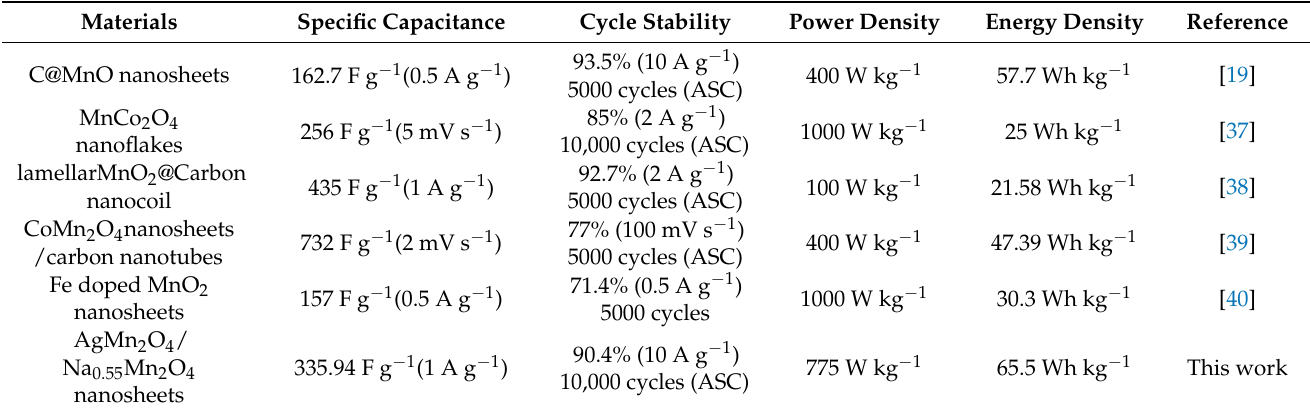
Table 1. Comparison of the electrochemical performance of AgMn 2 O 4 /Na 0.55 Mn 2 O 4 nanosheets with other previously reported two-dimensional manganese